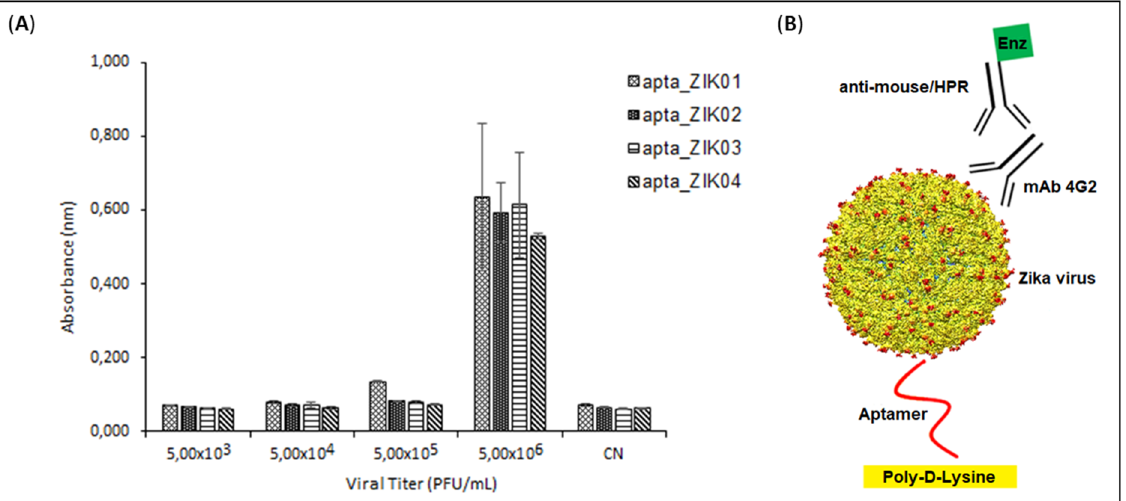
Figure 9. In-house ELISA: ( A ) Reactivity of the four aptamer clusters with the ES 2916/2015 Zika virus and negative control (no virus); and ( B ) Schematic representation of the test.